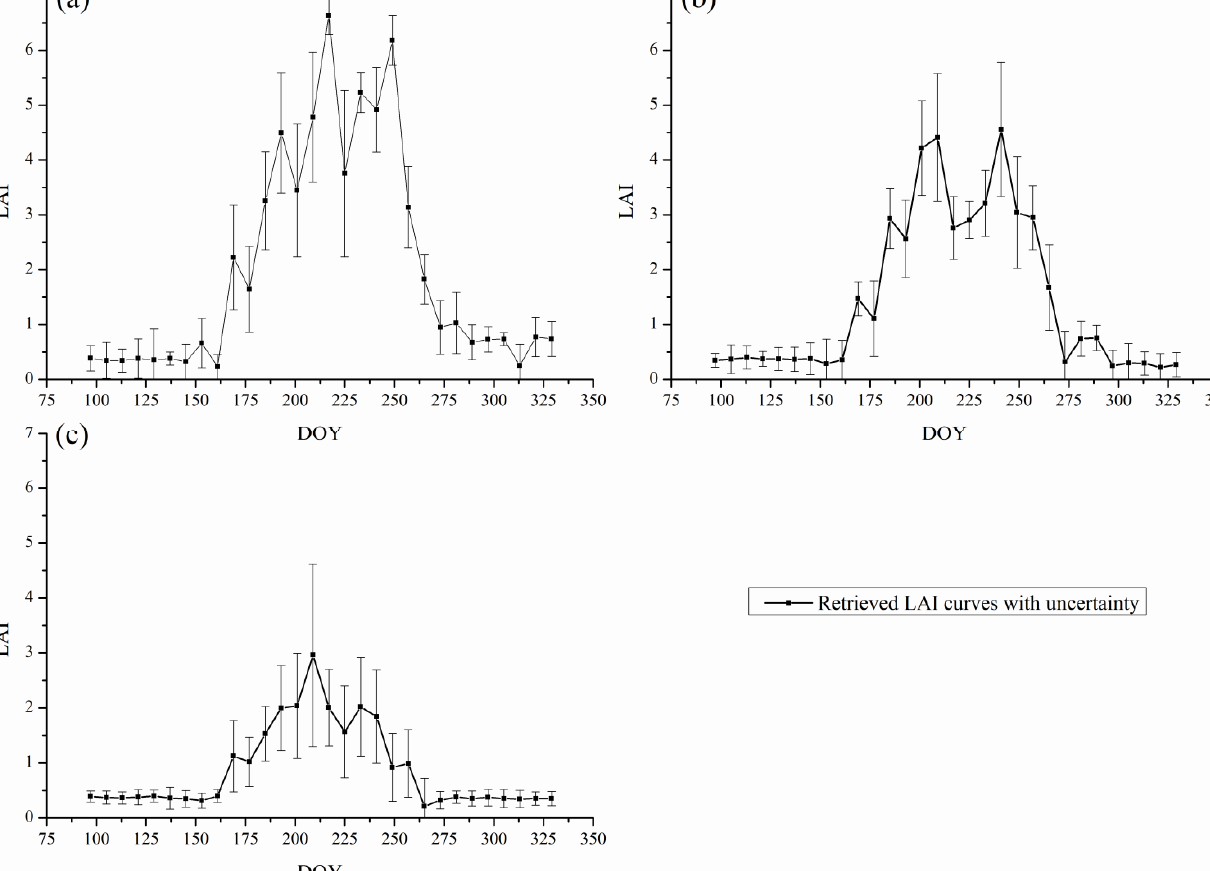
Figure 7. Comparison of the LAI r and LAI F for three pixels from dense vegetation to sparse vegetation in the time series. ( a ) and ( b ) are the LAI r of vegetation near Wutumeiren river; ( c ) is the LAI r of vegetation in drought area.